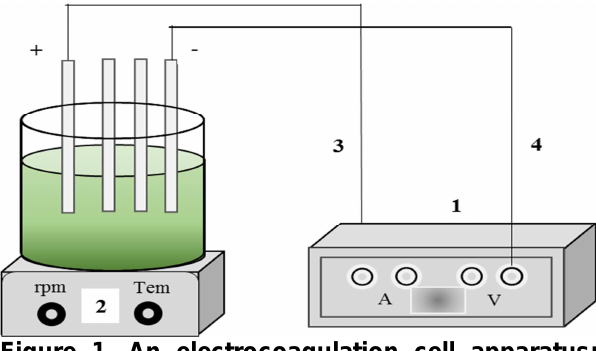
Figure 1. An electrocoagulation cell